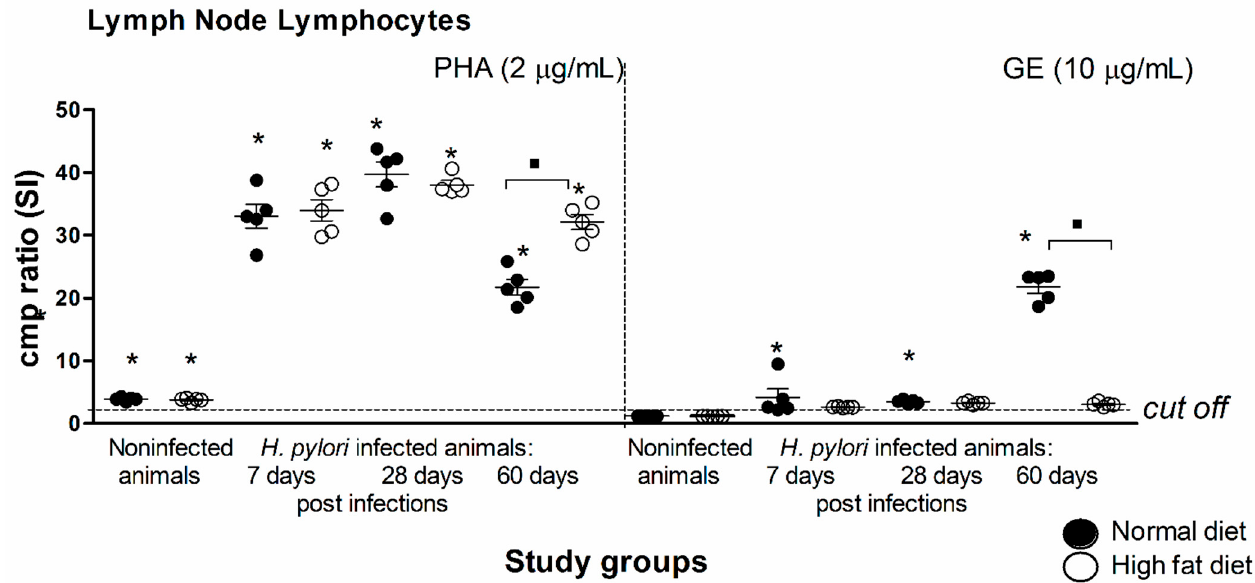
Figure 2. H. pylori antigen-driven proliferative response of lymph node lymphocytes in the single-stage cultures of total mesenteric lymph node leukocytes (tMLNL) incubated for 72 h with an H. pylori antigenic complex—glycine acid extract (GE) or phytohemagglutinin (PHA). The proliferating activity of the lymphocytes was evaluated based on (3 H )-thymidine incorporation. The stimulating index (SI) was calculated by dividing the radioactivity counts (cpm) for the cell cultures in the presence of the stimulus by the counts for control cell cultures in RPMI-1640 alone. Cells from 5 animals per group were examined. The results are shown as the SI ± SD. Statistical analysis was performed with the nonparametric Kruskal–Wallis test. Statistical significance, * p < 0.05 was obtained for H. pylori -infected animals fed a normal chow or a high-fat diet vs. the control animals, ▪ p < 0.05 was obtained for H. pylori -infected animals fed normal chow vs. fed a high-fat diet.